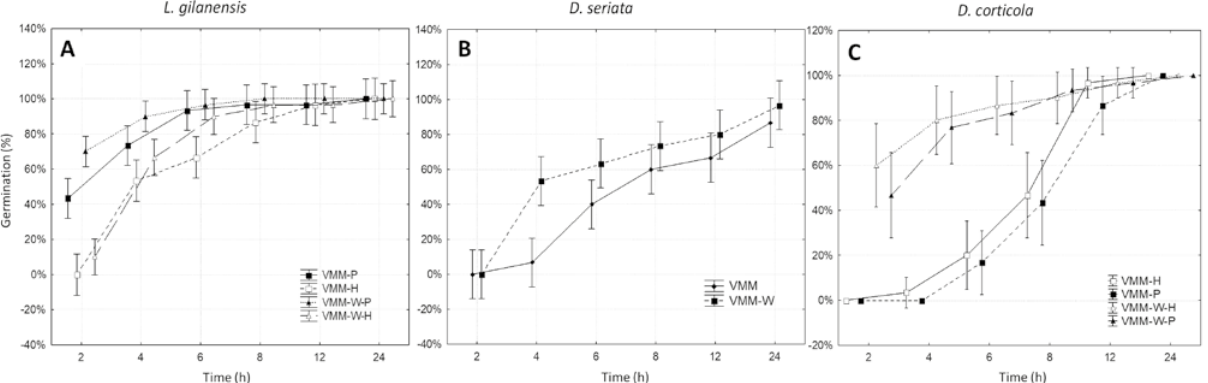
Figure 3. Mean germination proportions for pigmented (P) and hyaline (H) pycnidiospores of Lasiodiplodia gilaniensis (A), Diplodia cor- ticola (B), and D. seriata (C), grown in Vogel’s Minimum Medium (VMM) or VMM supplemented with grapevine wood (VMM-W). The presence of grapevine wood in the medium mostly affected germination of D. corticola